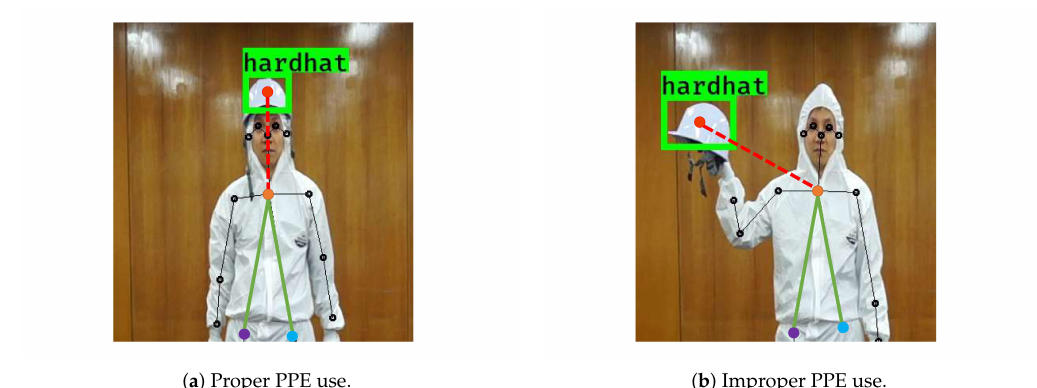
Figure 5. Proper PPE use identification strategies. Reference threshold β i ∗ ↔ j ∗ is calculated from the Euclidean distance among detected neck keypoints (yellow dots) and hip keypoints (purple and blue dots). ( a ) Proper PPE use is identified if the Euclidean distance (red lines) between the detected PPE positions (red dots) and detected neck keypoints is smaller than the reference threshold β i ∗ ↔ j ∗ ; ( b ) otherwise, the condition is identified as improper PPE use.